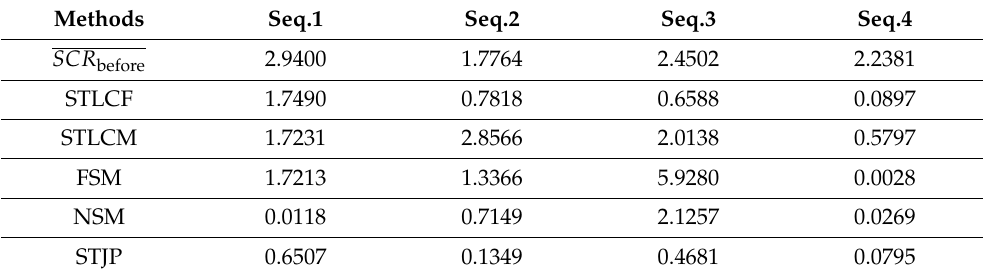
Figure 10. ROC curves and AUC values of different methods for the four sequences; ( a – d ) represent Seqs.1–4, respectively. Table 3. Average GSCR values of different methods for four